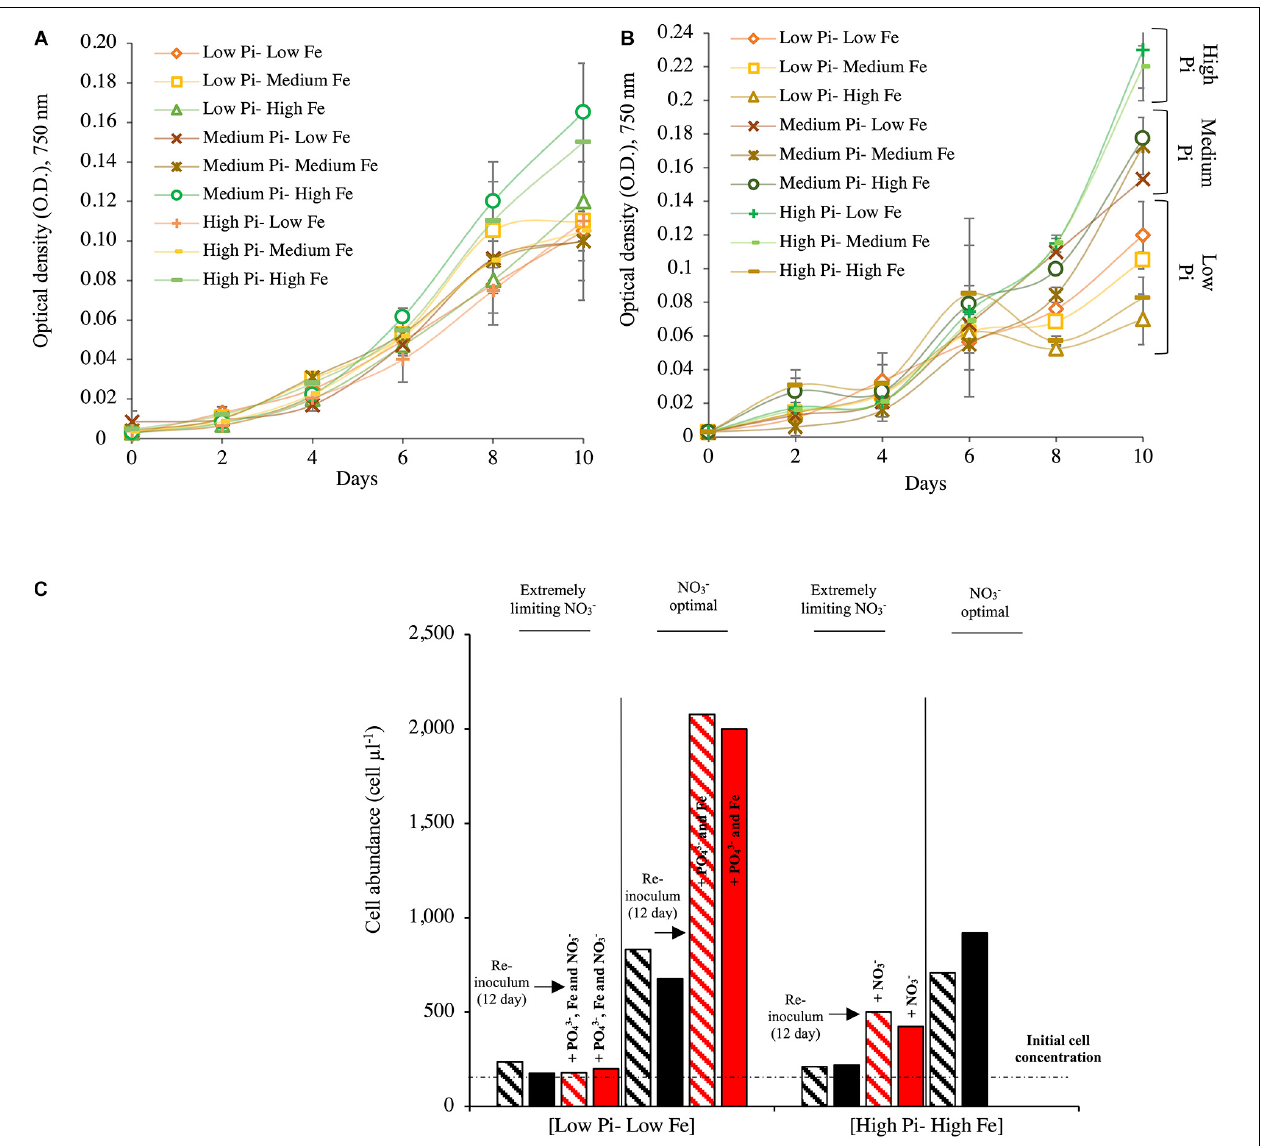
FIGURE 1 | Growth of Halothece sp. at different combinations of nutrient concentrations (PO 43 − , Fe, and NO 3 − ). (A) Growth for Halothece sp. under NO 3 − optimal conditions. (B) Growth for Halothece sp. under [Low NO 3 − ] conditions. (C) Cell concentration after 12 days of incubation and recovery of Halothece sp. under different NO 3 − concentrations with the re-inoculum (black arrow) of PO 43 − , Fe, and/or NO 3 − and incubated 4 days more (red bars). The initial cell concentration is referenced with the black dashed line. PO 43 − is represented as Pi. In panels (A,B) , values are the mean with their spanning range (SR) between the duplicate measurements. In panel (C) , data presented are actual values of the duplicates (striped and solid bars).